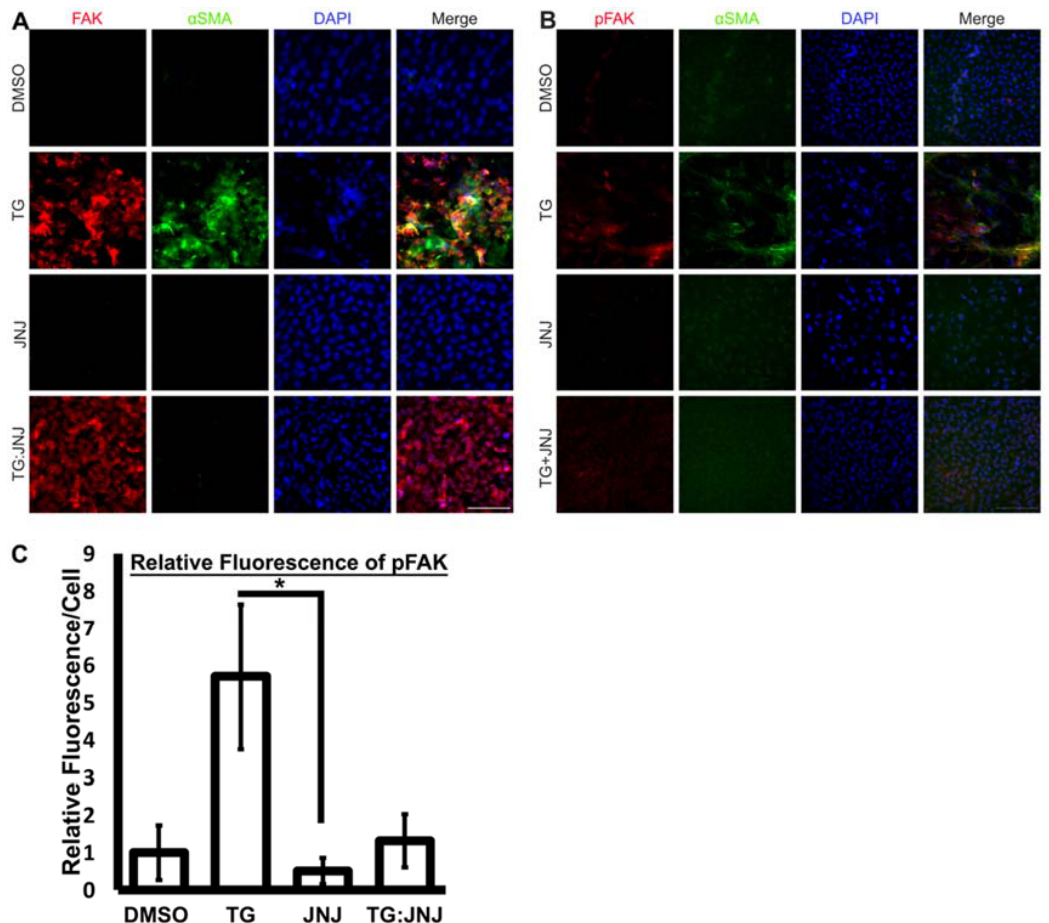
Figure 6. Expression of focal adhesion kinase (FAK) and phosphorylated FAK at Tyr397 (pFAK) upon MMP9 inhibition. Rat LEC explants were treated with DMSO, with 6 ng/mL TGF- β for 48 h (TG), with 20 µ M JNJ0966 (JNJ) for 48 h, or pretreated with 20 µ M JNJ0966 for 2 h followed by 6 ng/mL TGF- β for 48 h (TG:JNJ) ( n = 3 independent experiments, where n ≥ 3 LECS per treatment were used for each experiment). Paraformaldehyde (PFA) fixed explants were stained for FAK ( A ; red) and pFAK ( B ; red) and α SMA ( A , B ; green), and mounted with DAPI to visualize the nuclei. Images were acquired using Leica DM6 fluorescence microscope at 40 × . Scale bar, 100 µ m. ( C ) Graph showing mean pFAK fluorescence per cell relative to LECs treated with DMSO. Fluorescence per cell was acquired using Image J ( n = 3 LECs per treatment). Error bars indicate ± SEM of the relative mean fluorescence (One-Way ANOVA shows * p < 0.05; Tukey’s Test shows * p < 0.05 between TG LECs and JNJ LECs).